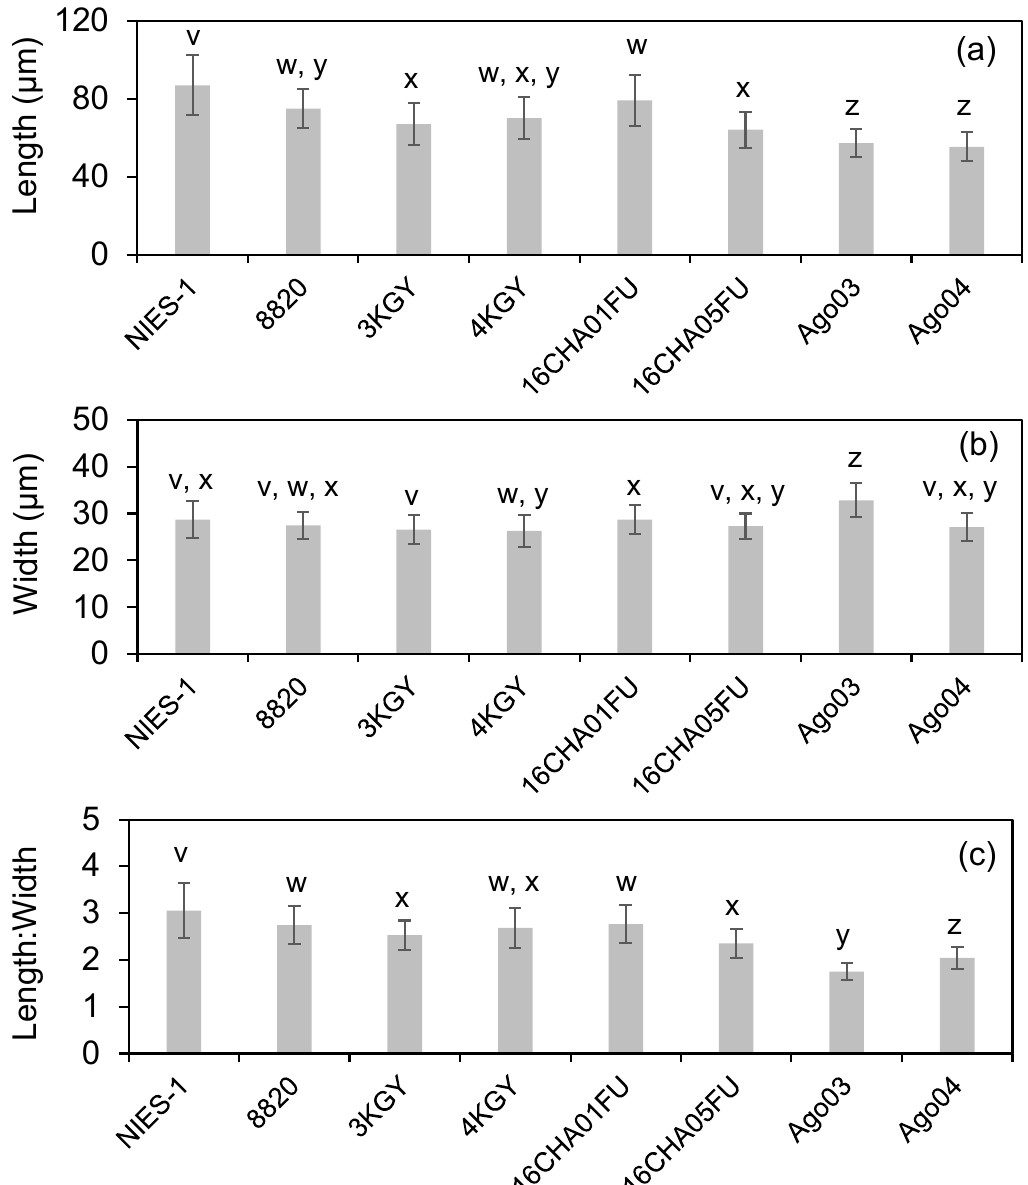
Figure 4. Length ( a ) and width ( b ) of cells and the length:width ratio ( c ) of Chattonella strains ( n = 60). Each bar represents the mean ± SD of triplicate measurements. Means that are not significantly different are labeled with the same letter (v–z; p < 0.05).